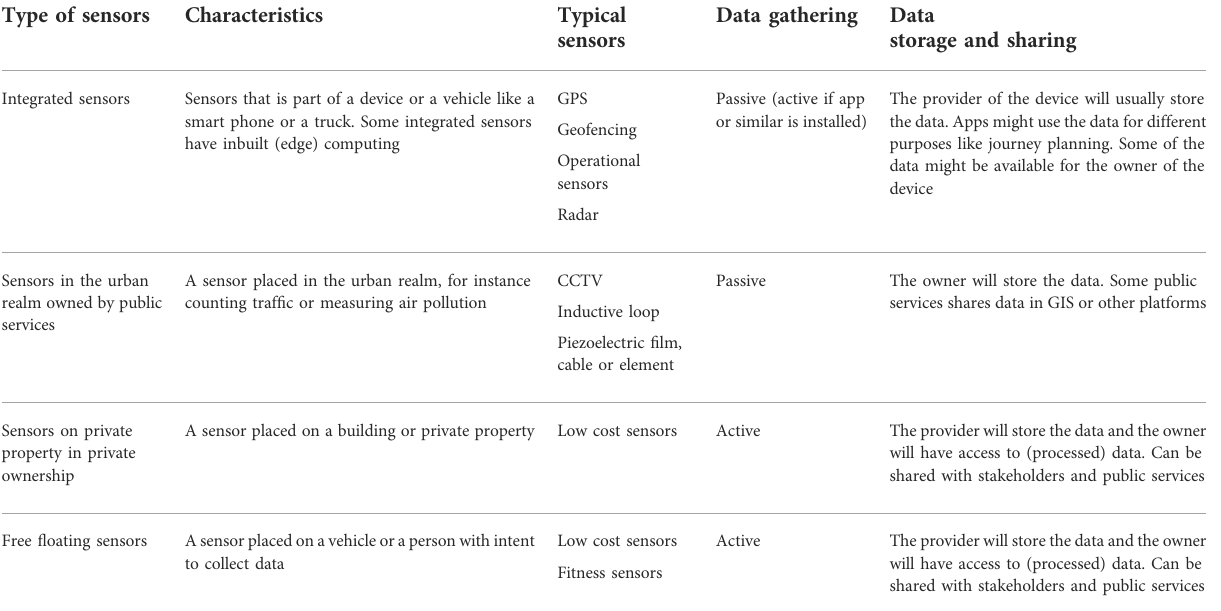
TABLE 1 Different types of sensors with different characteristics and